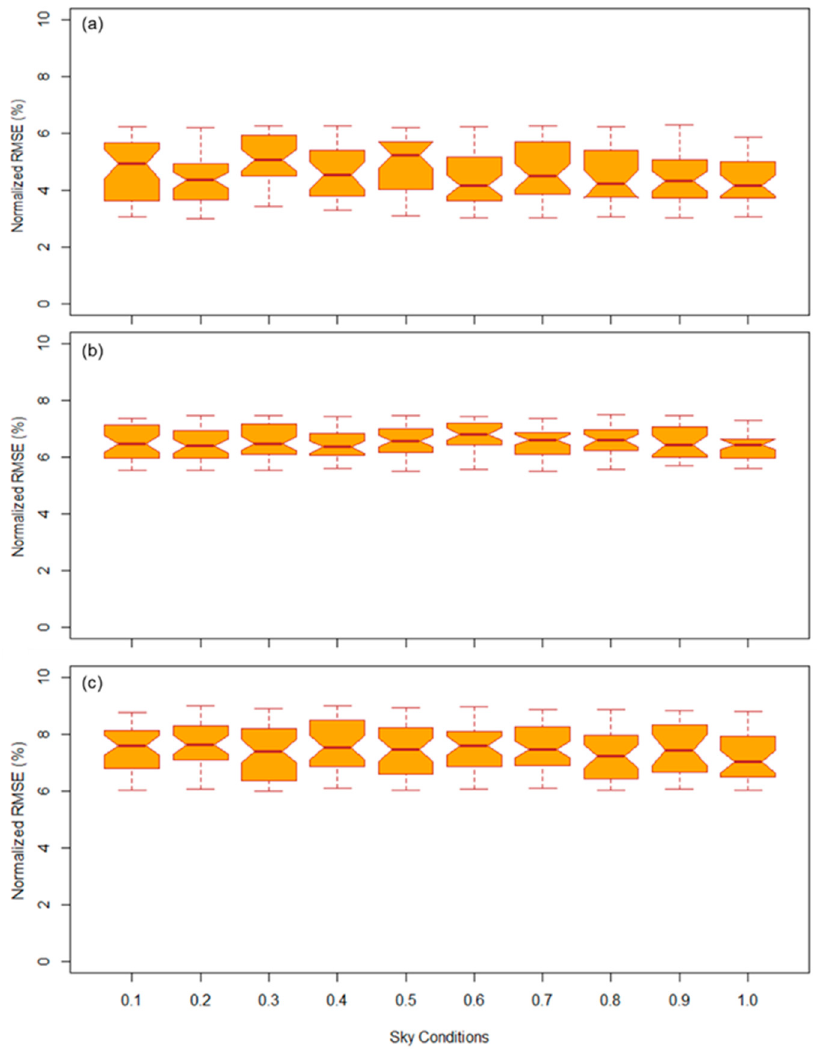
Figure 6. Boxplot of daily nRMSE accuracy at different sky conditions over the test set evaluation period for the optimally trained machine learning models of: ( a ) Bayesian neural network (BNN); ( b ) support vector regression (SVR); ( c ) regression tree (RT). The red line indicates the median